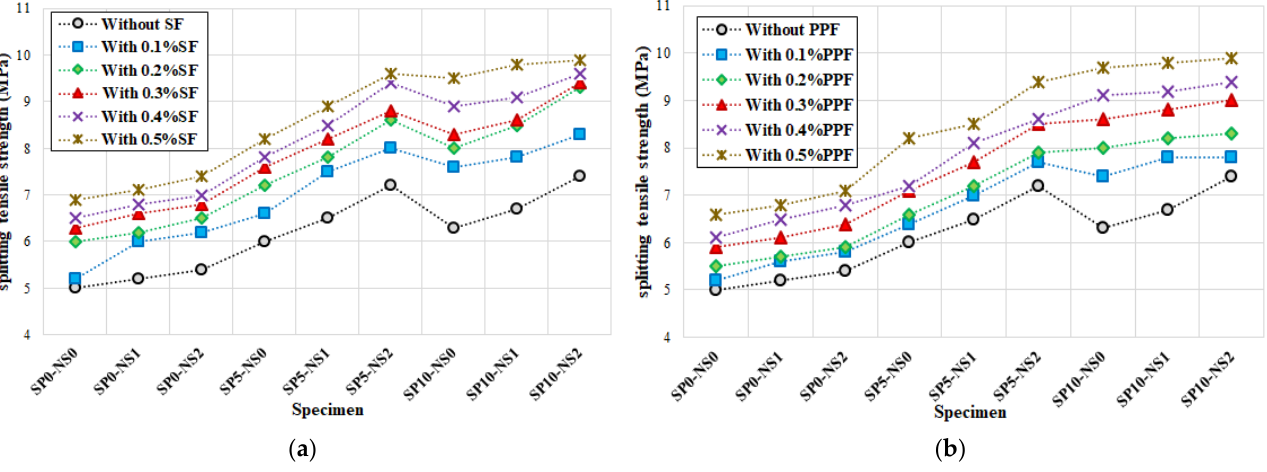
( b ) Figure 11. Effect of the fibres on the splitting tensile strength of HSC containing ( a ) NS and ( b ) SP. 5.4. Compressive-Splitting Tensile Strength Relationship Figures 12 and 13 illustrate the correlation between the splitting tensile and compres- sive strengths of HSC with various contents of SF, PPF, NS and SP. Besides, formulas are proposed to consider the effect of SF and PPF. The proposed relationships (with R2 above 0.83) are high-fitting with the experimental results.